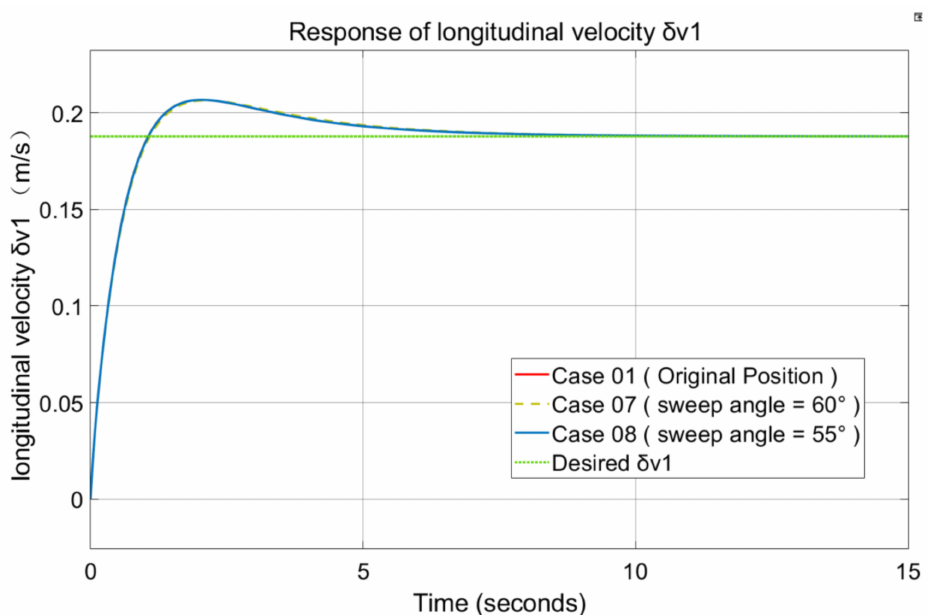
Figure 25. Response of the longitudinal velocity ( δ v 1 ) with controller (cases 01, 07 and